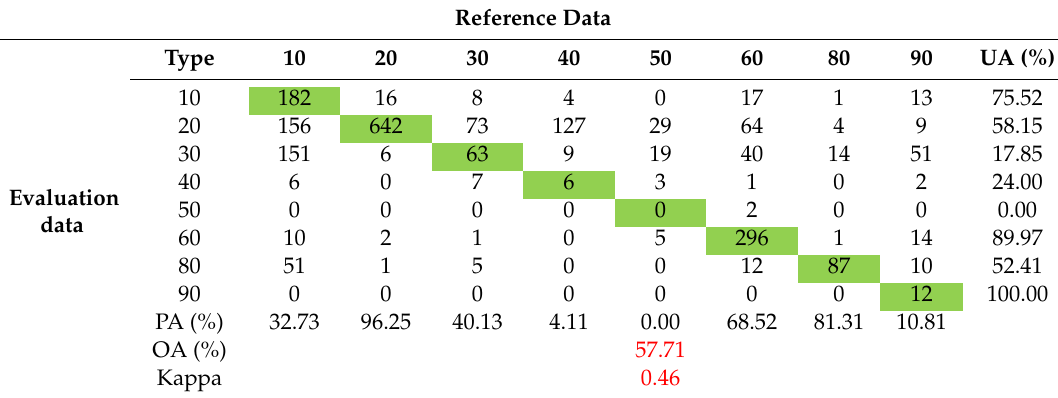
Table 11. FROM_GLC2015 confusion